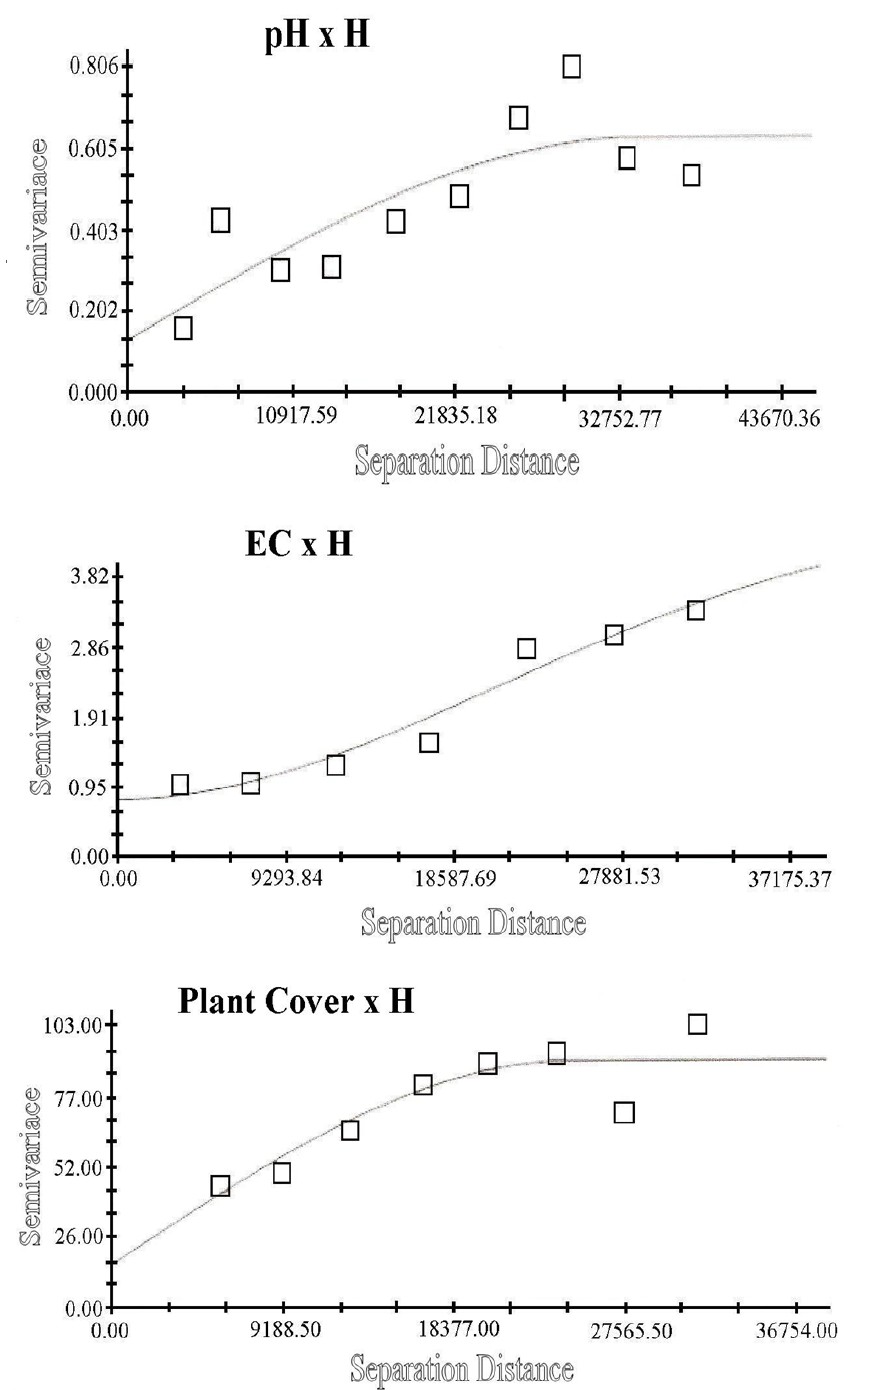
Fig. 3. Cross-variograms related to different factors in cokriging